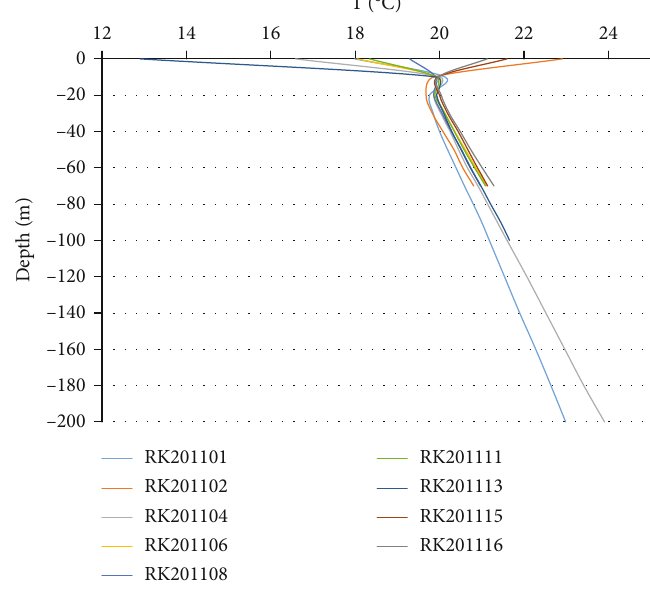
Figure 6: The average ground temperature of the monitoring hole changes with